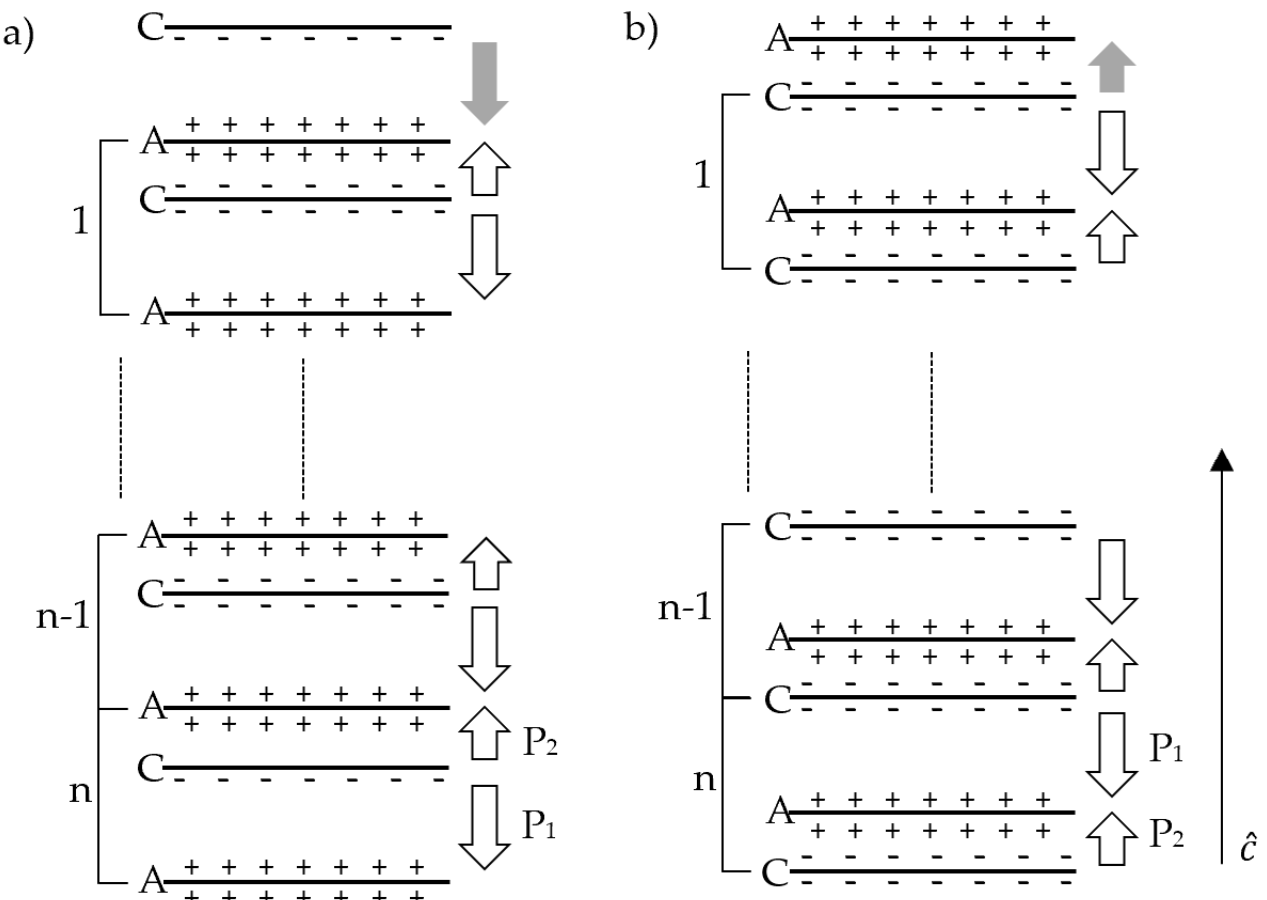
Figure 3. Depiction of layering structure where A is the anion and C is the cation of a binary wurtzite structure in the c-direction. ( a ) is case 1 where there is an extra cation at the surface that is not cancelled out with each “layer” consisting of an A-C-A bond. ( b ) represents the other possible case, case 2, where there is an extra anion at the surface that is not cancelled out. Each layer in case b consists of a C-A-C bond. In the case of SiC where it is not easy intuitive as to which is the anion and which is the cation, Si is the cation and C is the anion.